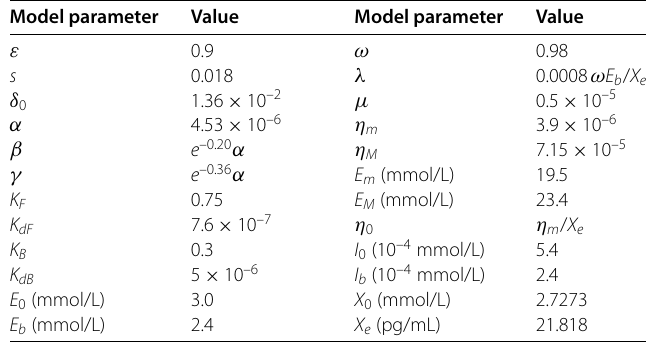
Table 1 Values of parameters in the calcium model Model parameter Value Model